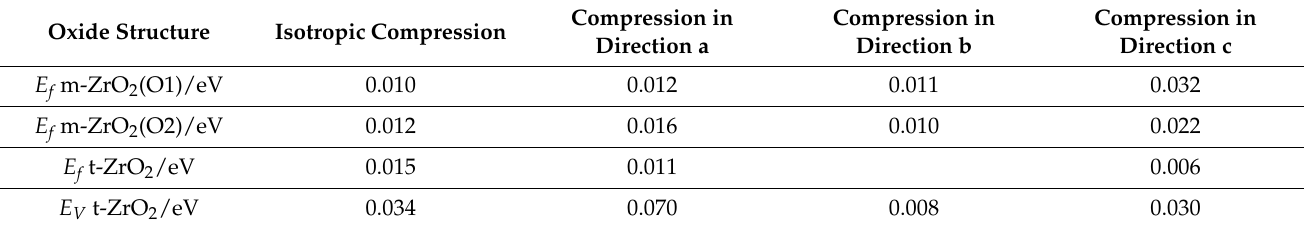
Table 3. Energy of oxygen vacancy formation ( E f ) and migration ( Ev ) for different ZrO 2 modifications depending on the direction of a compressive stress of 1 GPa